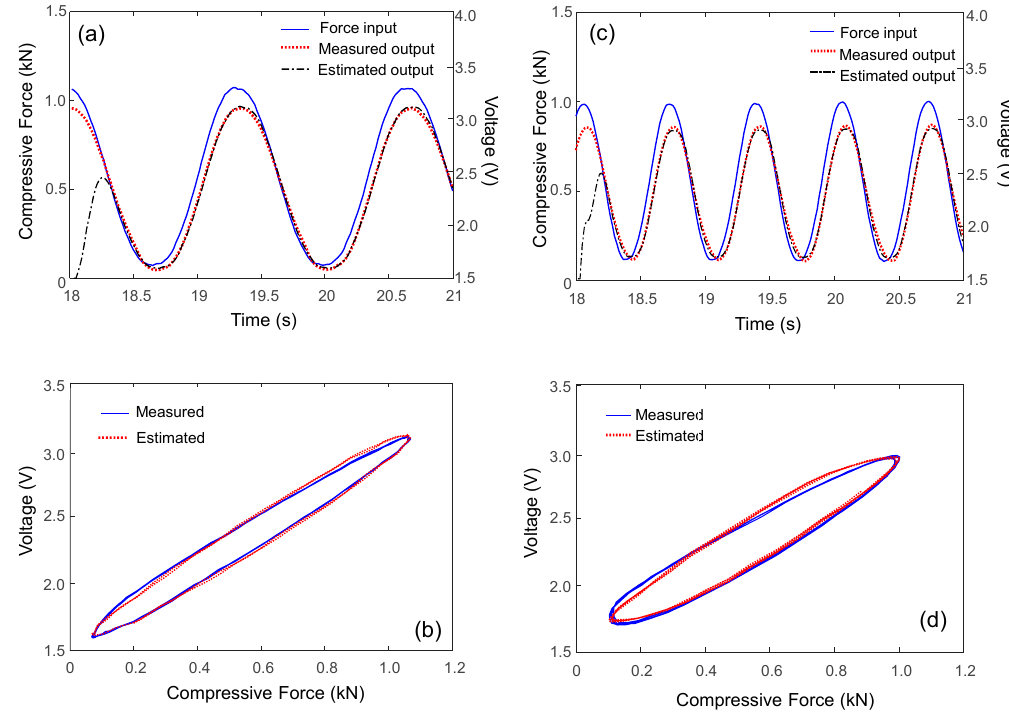
Figure 10. Estimated output based on Duhem hysteresis model. ( a , b ) 0.75 Hz; ( c , d ) 1.5 Hz.